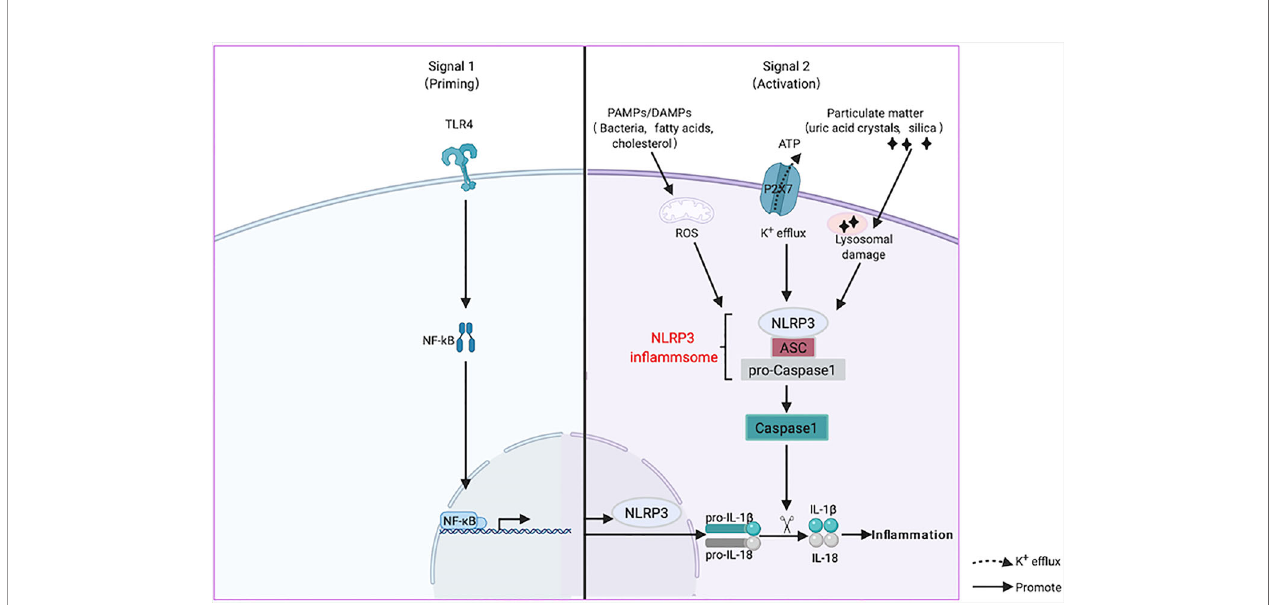
FIGURE 2 | Activation mechanism of nucleotide-binding oligomerization domain-like-receptor family pyrin domain-containing 3 (NLRP3) in fl ammasome. NLRP3 is activated by two signals when it senses the stimulation of aging or estrogen de fi ciency through toll like receptors (TLRs). The fi rst priming process (Signal 1) is the expression of NLRP3 and in fl ammatory factors under the action of the NF- k B transcription factor. Next, it induces uniform downstream host-derived cellular events, including K + ef fl ux, Ca 2+ ef fl ux, reactive oxygen species (ROS) generation, and lysosomal damage. ASC is an adaptor molecule responsible for connecting NLRP3 and caspase-1 precursors, and then recruits the precursor caspase-1 into an activated form (Signal 2). Activated caspase-1 cleaves the precursors of IL-1 b and IL-18 into mature forms and causing in fl